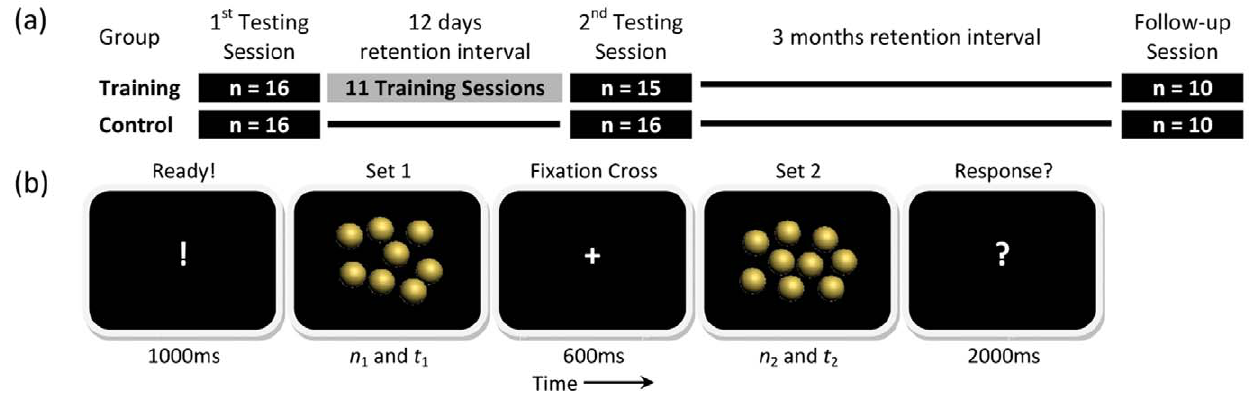
Figure 1. Design of the study. (a) Procedure of the study. (b) Procedure of a trial in testing and training sessions. Refer to the text for description of n and t.